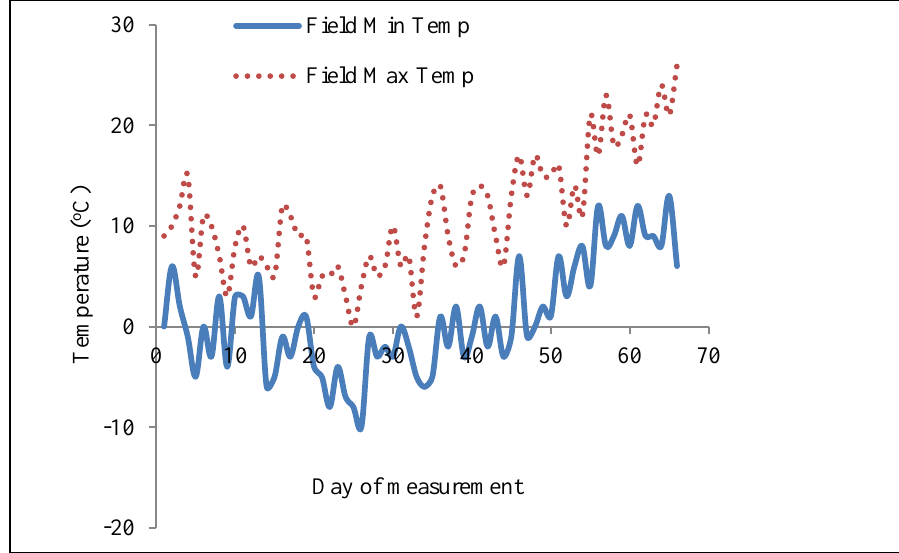
Figure 2. Minimum and maximum temperature in the field with respect to day of measurement.